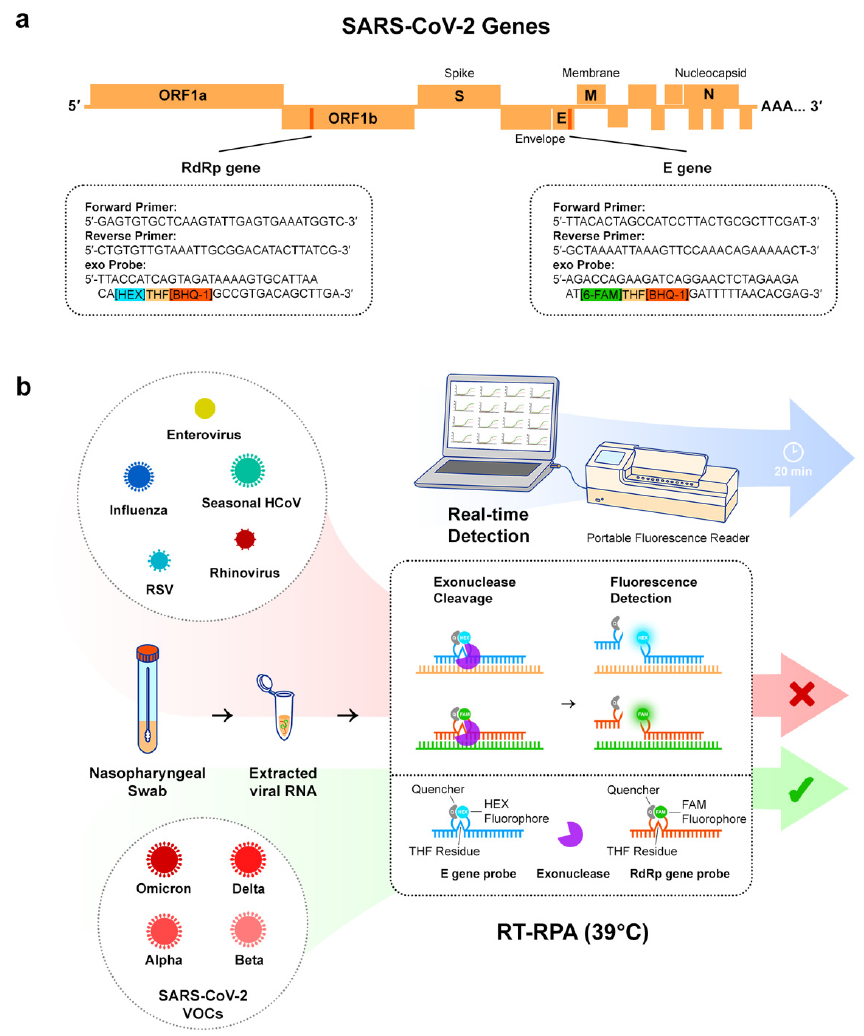
Figure 1. Schematic illustration of the one-pot RT-RPA multi-gene assay. ( a ) Representation of SARS-CoV-2 genes and sequences of the primers and exo probes used for the E and RdRP gene targets. ( b ) Nasopharyngeal swabs from patients were tested. After extraction of viral RNA from the swabs, the samples were screened with the multi-gene RT-RPA assay (isothermal amplification at 39 °C) with an amplification time of 20 min. The validation panel included SARS-CoV-2 variants of concern (VOCs) and other respiratory pathogens.